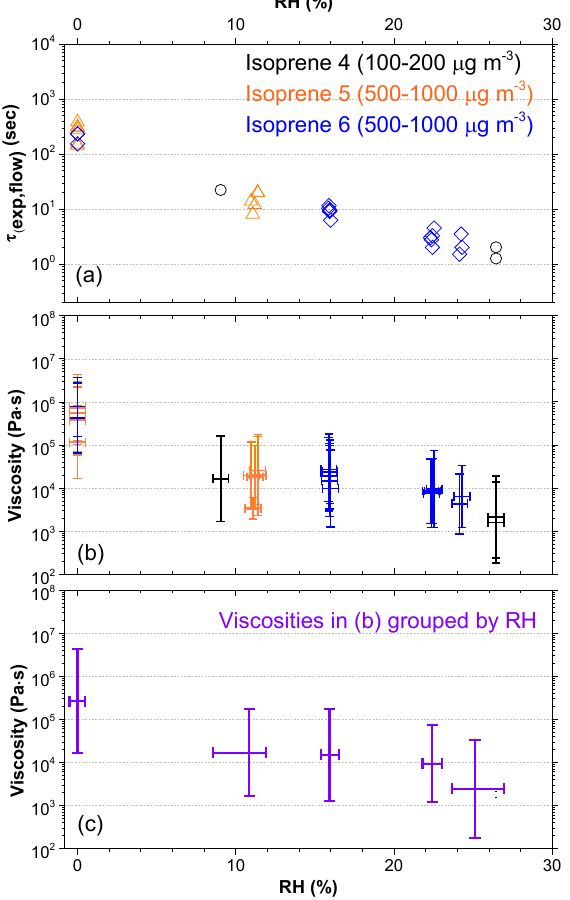
Figure 7. Results from the poke-flow experiments: (a) τ ( exp , flow ) measured for the different samples. Each symbol represents the measured τ ( exp , flow ) from poking one particle at one RH. (b) Vis- cosities calculated from τ ( exp , flow ) where y error bars represent the calculated lower and upper limits of viscosity using the simulations. The x error bars shown in (b) represent the range of RH values in a given experiments and uncertainty in the RH measurements. (c) Viscosities from the different samples grouped by RH. At least four data points were included in each group. The x error bars represent the lowest and highest RH ranges in the group and the uncertainty in the RH measurements, and the y error bars represent the lower and upper limits of viscosity within the